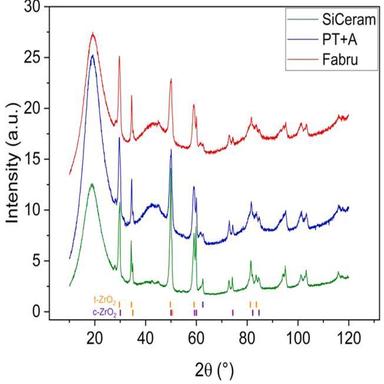
XRD patterns of the sintered filaments. Measurements have been performed on the polished face of the filaments, embedded in a polymer matrix. Broad humps around 20◦ and 45◦ are due to the amorphous polymer contribution. Orange and violet lines represent the positions of the XRD peaks for the cubic and tetragonal YSZ phases, respectively. (green) SiCeram; (blue) PT+A; (red) Fabru.